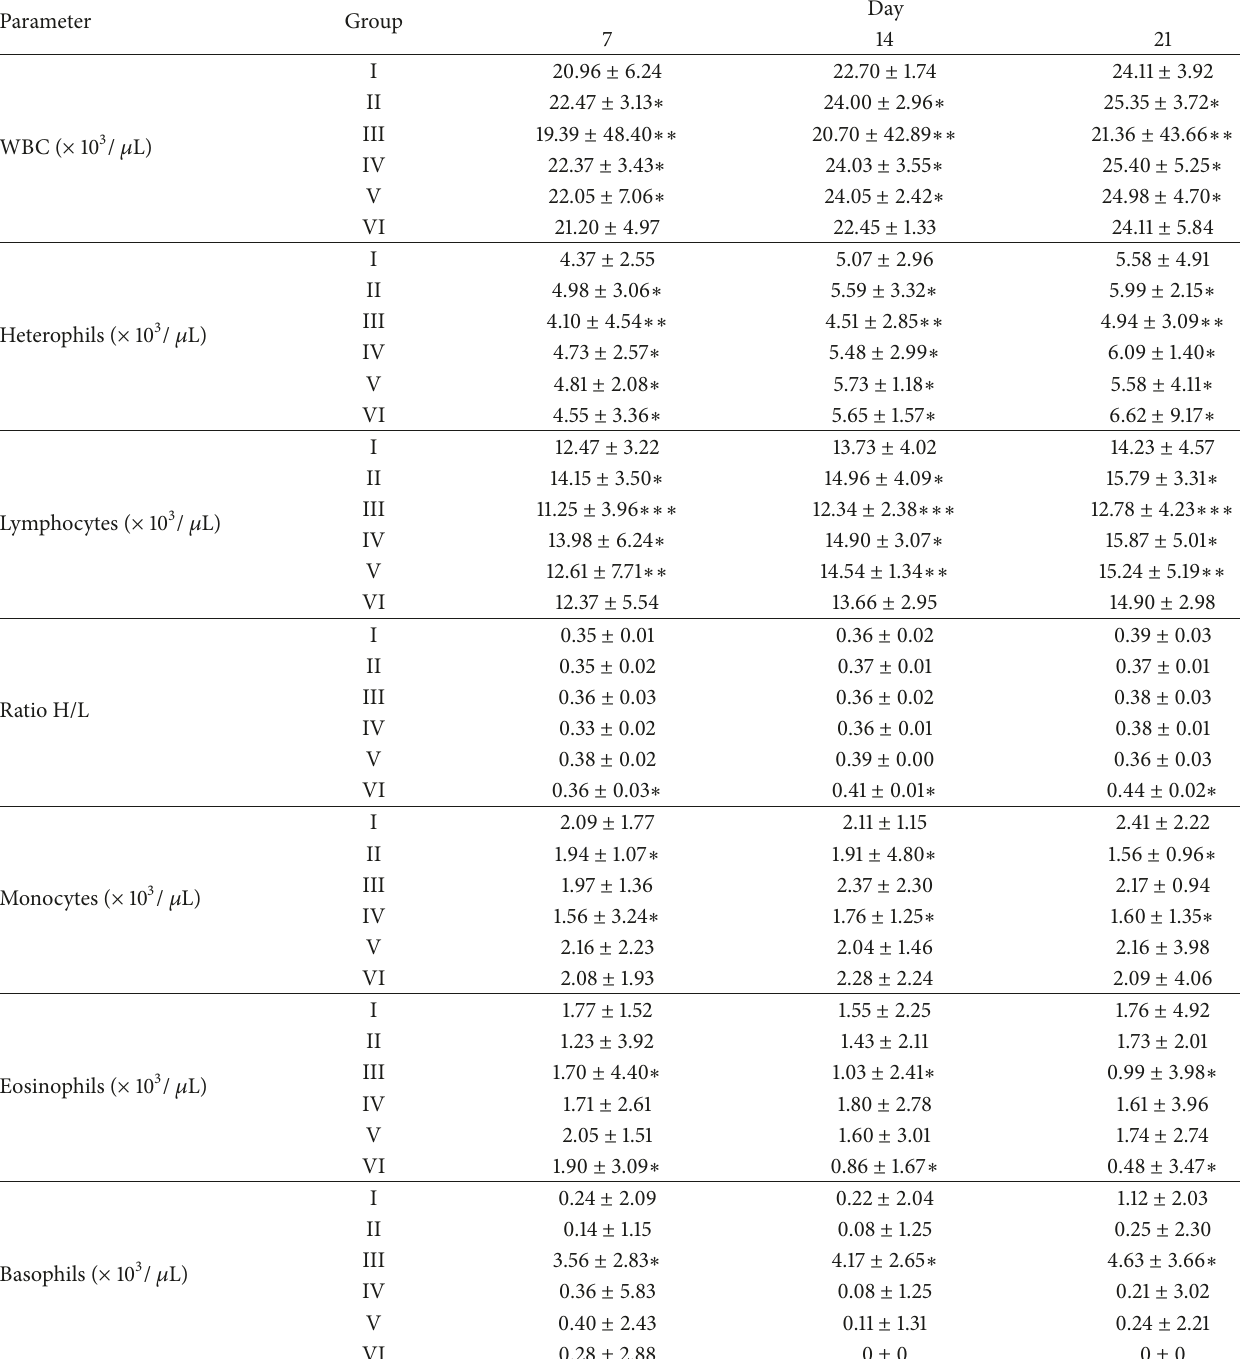
Table 7: Effects of 5% SAP on the haematological profile (WBC and differential leucocytes count) of broiler chickens fed a diet naturally contaminated with AF at 7, 14, and 21 days of